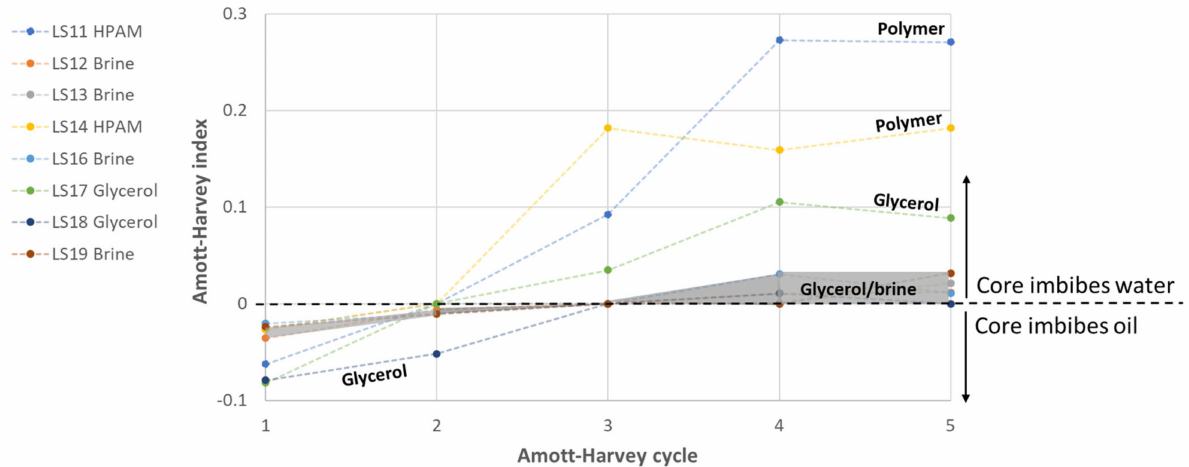
Figure 8. Wettability development during five Amott–Harvey cycles where the aqueous phase was polymer, glycerol, or brine (shaded area). The brine/oil cores were previously described in [17], and the figure modified from [26].